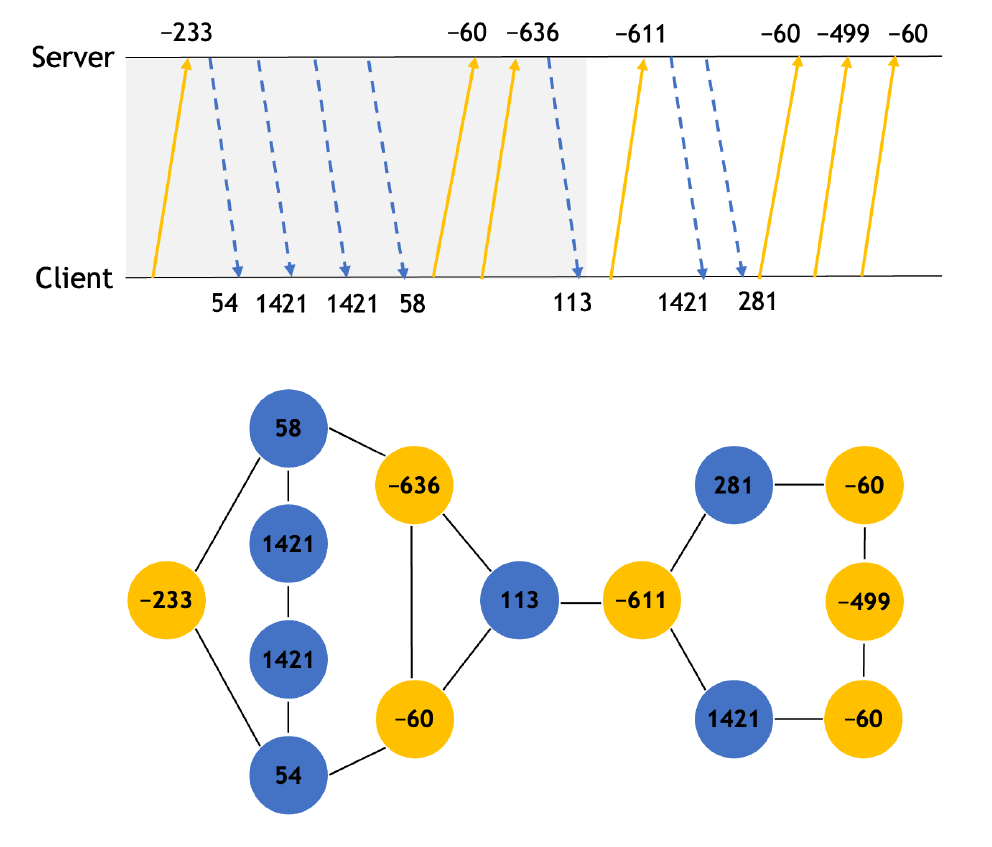
Figure 1. An example of the traffic interaction graph (TIG) from a Angler-EK sample. The minus sign indicates that the corresponding packet is sent from client to